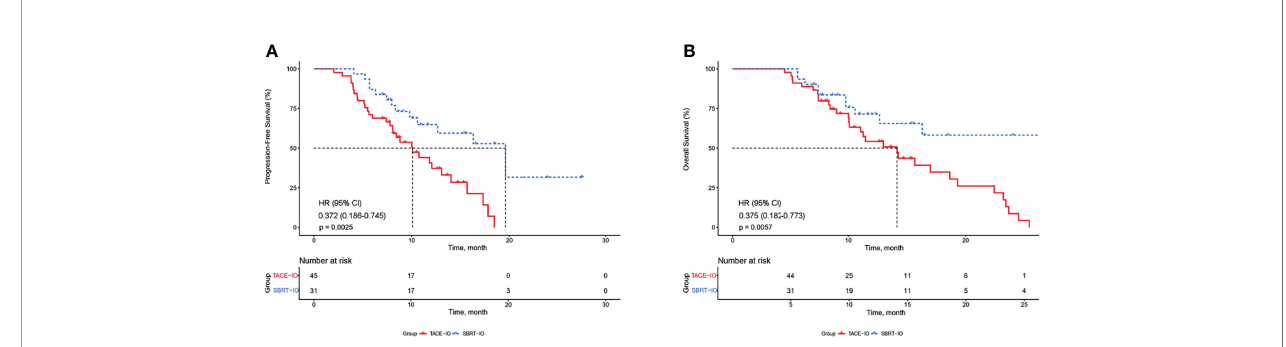
FIGURE 2 | Kaplan – Meier estimated PFS and OS curves of HCC patients receiving different therapies. (A) PFS; (B) OS. PFS, progression-free survival; OS, overall survival; HCC, hepatocellular carcinoma; TACE, transarterial chemoembolization; SBRT, stereotactic body